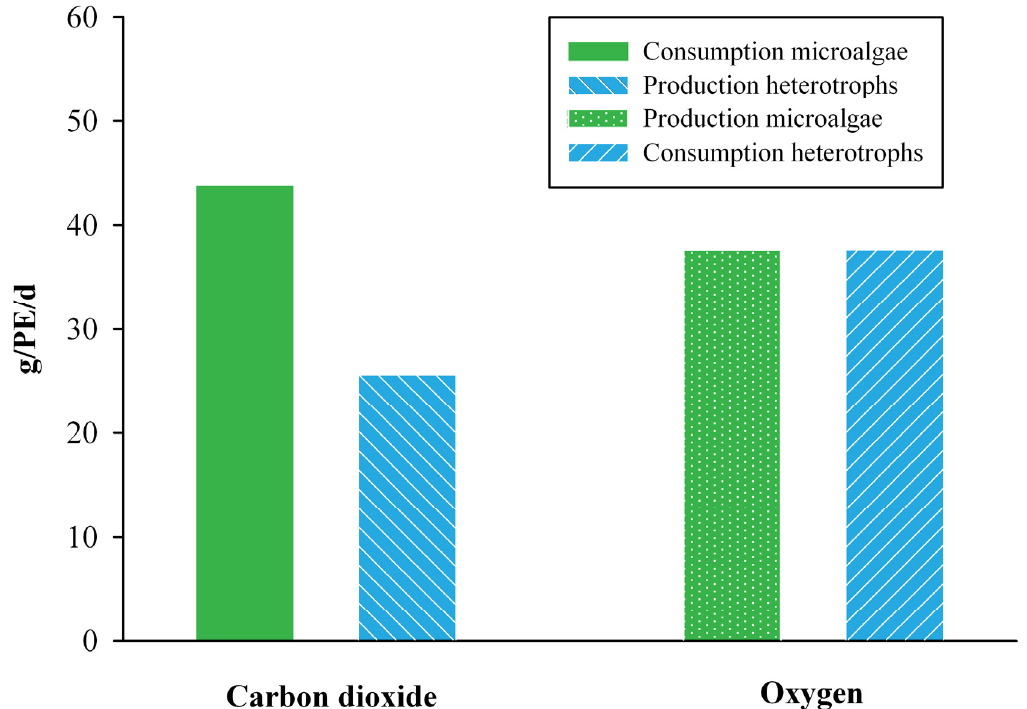
Figure 2. The consumption of CO heterotrophs, and the production of O heterotrophs in the symbiotic system of Scenario 3. The amounts are expressed in gram per person equivalent (PE) per